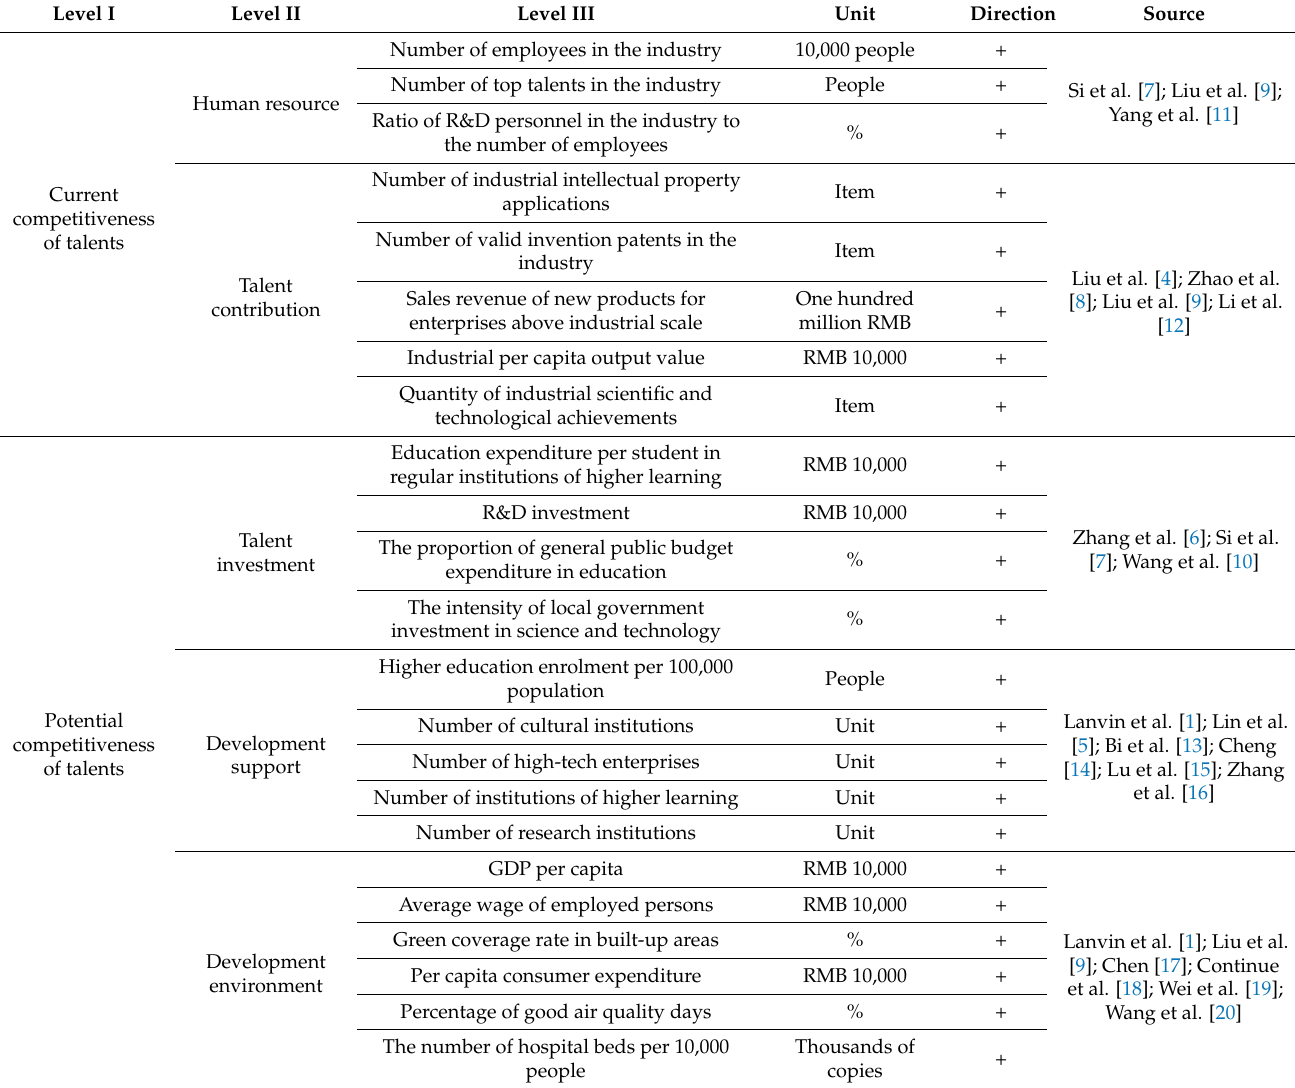
Table 1. Talent competitiveness evaluation index system of the intelligent